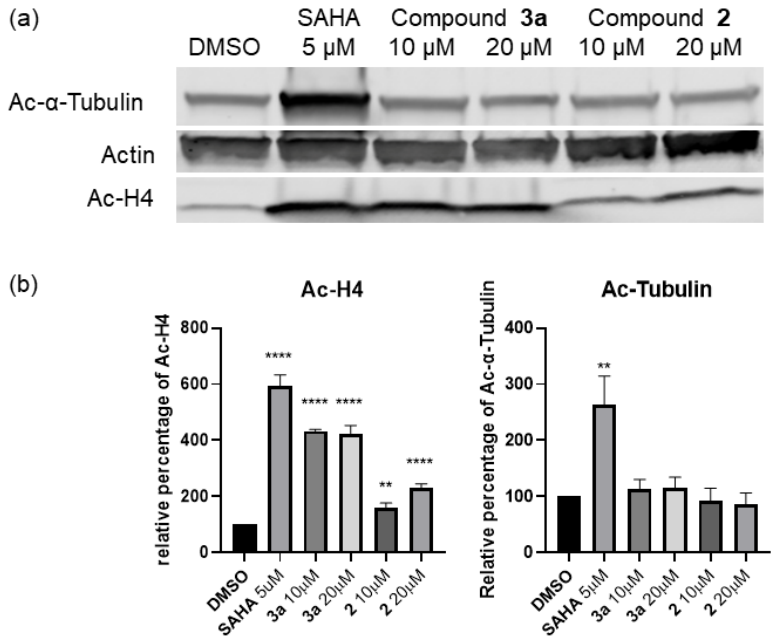
Figure 4. Compounds 2 and 3a demonstrate selective class I HDAC inhibition in HepG2 cells. ( a ) The immunoblot of acetylated H4 and acetylated α -Tubulin in the Hep-G2 cell line treated with 0.1% DMSO or 0.1% DMSO solution of SAHA (5 µ M), 3a (10, 20 µ M) and 2 (10, 20 µ M) for 6 h. ( b ) Quantification of immunoblot obtained, averaging data from two independent experiments. (Bars show mean plus standard deviation; ** p < 0.0021; **** p < 0.0002).